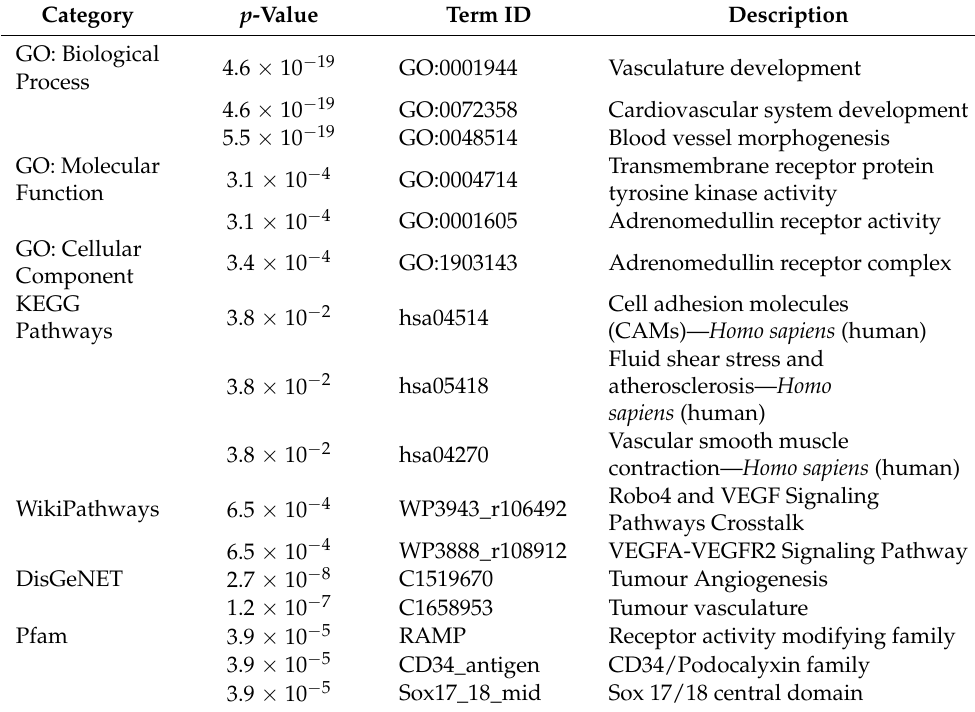
Table 10. Selected top gene term enrichments of the coexpressed genes to NRP1 in